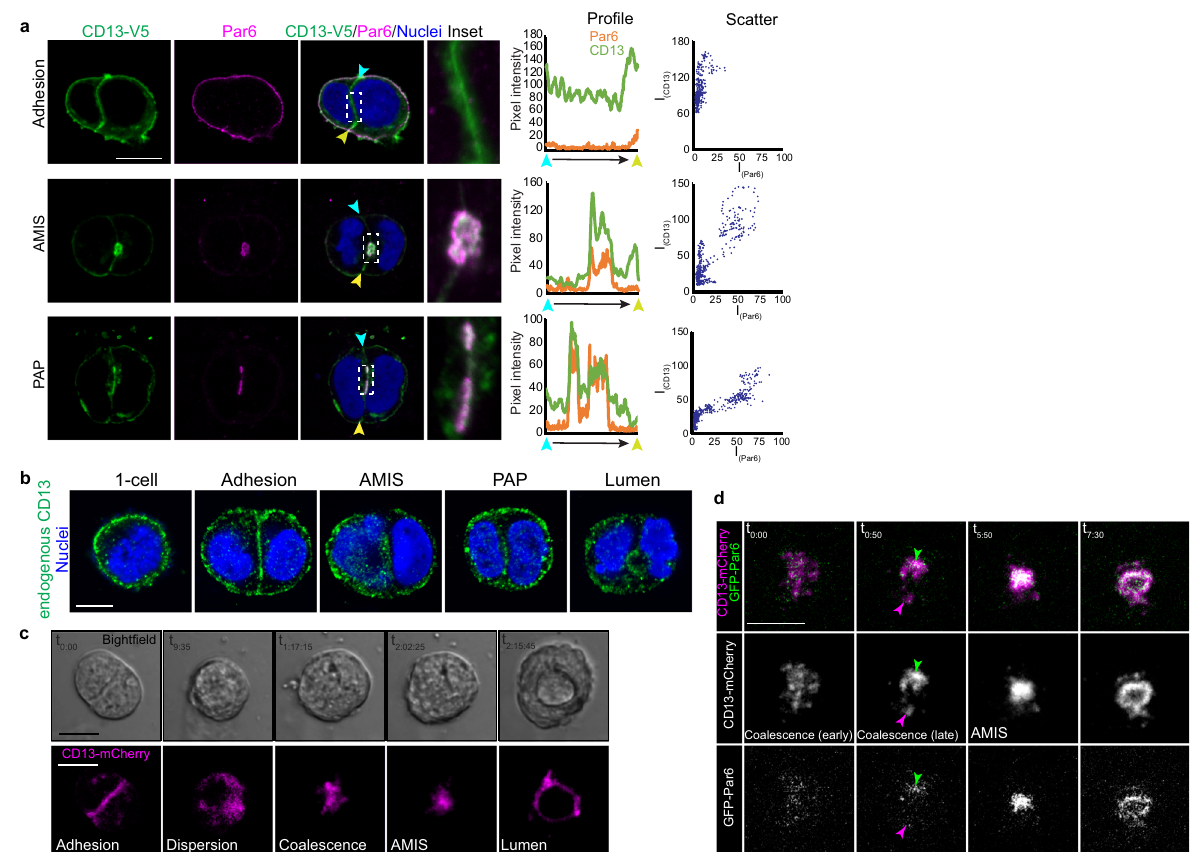
Fig. 3 CD13 is recruited to the apical membrane-initiation site before Par6 in 3D Caco-2 cysts. a Confocal images of 2-cell Caco-2 spheroids immunostained for CD13-V5 (green) and Par6 (magenta) showing the localization of CD13 and Par6 at adhesion, AMIS, and PAP stages. Middle - pro fi les depicting fl uorescent intensity (8-bit) of CD13 and Par6 along the cell-cell edge from blue to yellow arrows. Right - Scatter plots showing the relationships between Par6 and CD13 pixel intensities. b Confocal images from Caco-2 cells immunostained for endogenous CD13 during polarization and early lumen formation stages (1-cell, adhesion, AMIS, PAP, lumen). c , d Caco-2 cells were lentivirus-infected to express CD13-mCherry and EGFP-Par6 vectors in 2D culture, then transferred to 3D culture to initiate cell polarization. Time-lapse confocal images were captured every 25 min. Between adhesion and AMIS stages, CD13 disperses into puncta that coalesce into an AMIS that subsequently opens to form a lumen ( c ). During coalescence, CD13-puncta accumulation precedes incorporation of Par6 at the AMIS ( d ). Images are representative from three independent experiments. Bars: a – d , 10 μ